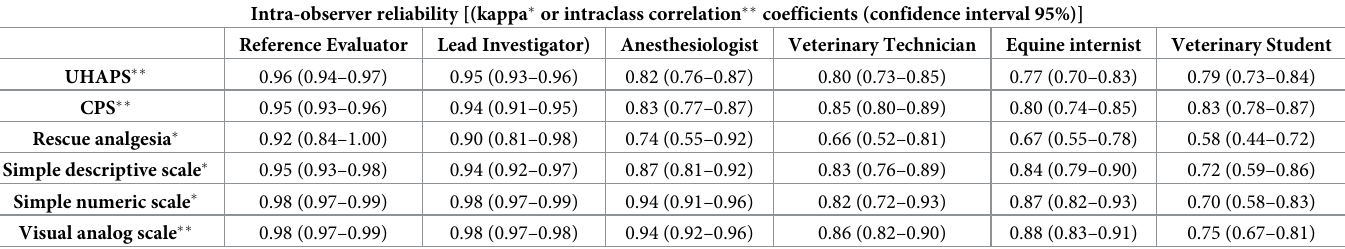
Table 2. Repeatability of the Unesp-Botucatu horse acute pain scale (UHAPS), Composite Pain Scale (CPS), and unidimensional scales to assess perioperative pain in